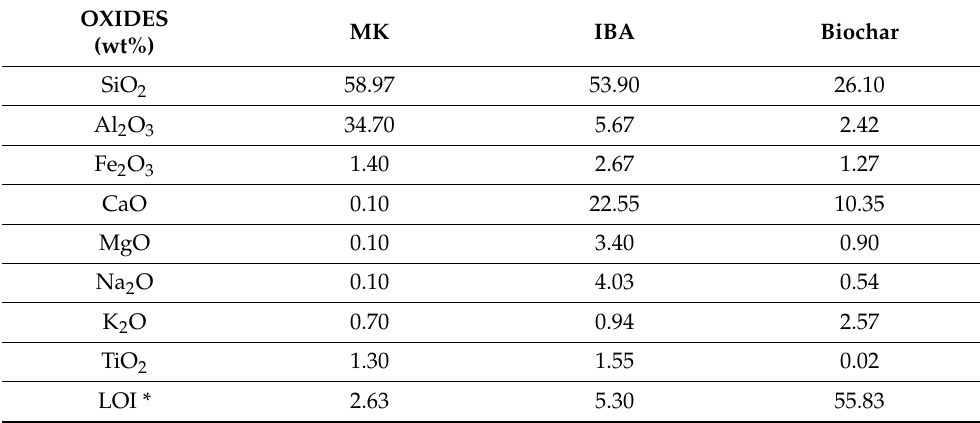
Table 2. Chemical analysis of MK, IBA, Biochar.